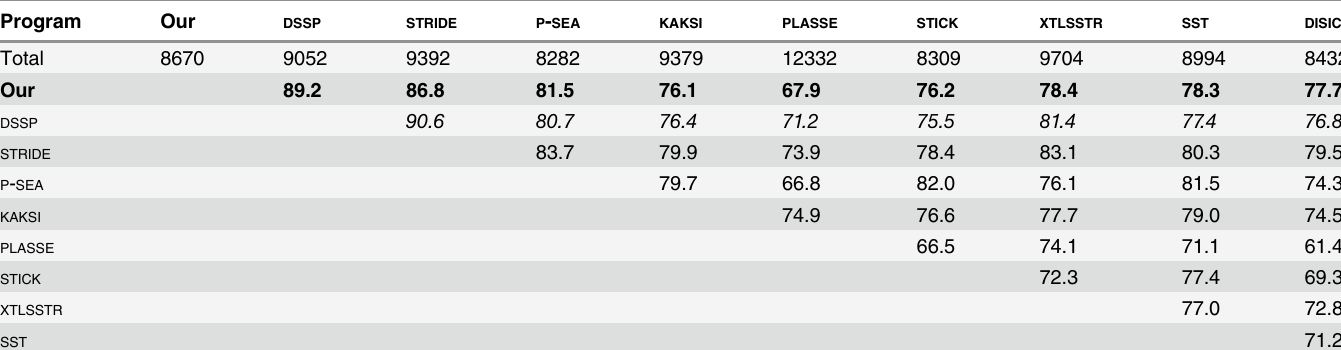
Table 4. The assignments on T by our algorithm and the nine previous programs. The assignments are made for a set of 100 x-ray structures with differ- ent resolutions. The first row is the total number of residues. All the other rows are the agreement between a pair of programs in percentage. The percentage where n is the number of residues assigned by both programs while n 1 and n 2 are respectively the numbers of residues assigned only is computed as n n 1 þ n þ n 2 by the fi rst and second